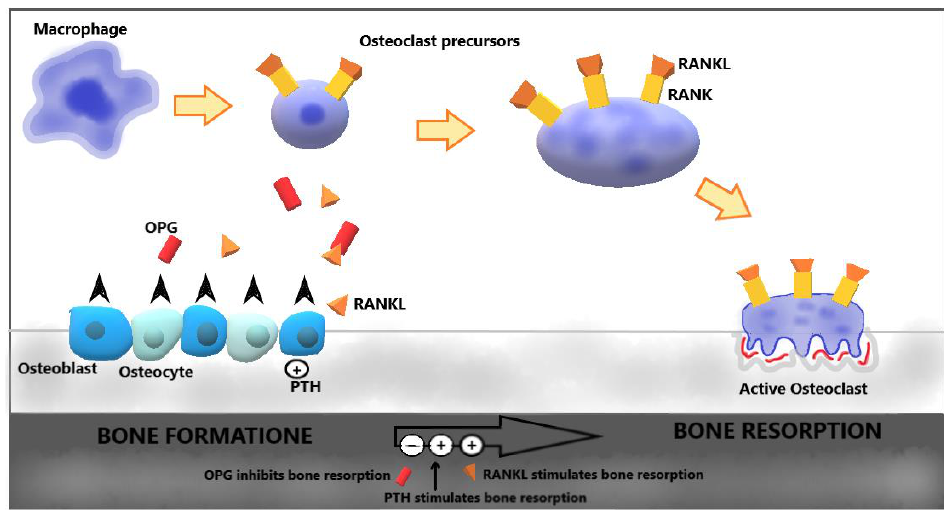
Figure 1. The nuclear factor- κ B receptor activator (NF- κ B) RANK / RANKL / OPG pathway. The production of nuclear factor- κ B receptor activator (NF- κ B) ligand (RANKL) leads to a greater di ff erentiation of macrophages into osteoclasts. Bone resorption is stimulated by active osteoclasts, RANKL, and parathyroid hormone (PTH), while it is inhibited by osteoprotegerin (OPG).